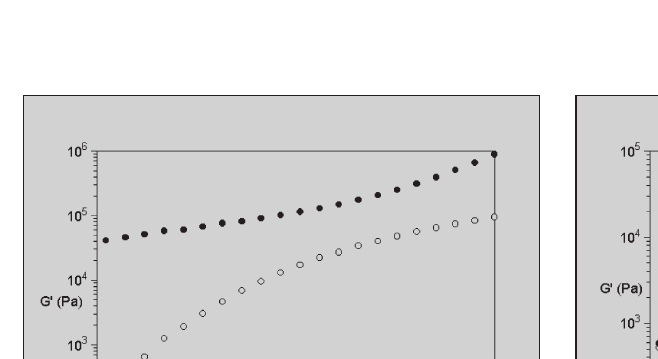
Figure 1 (left): Storage modulus as a function of frequency for iBMA at two temperatures ( (cid:122) : 80°C; (cid:129) : 160°C). Figure 2 (right): Influence of annealing at 125°C on the storage modulus of a heterogeneous blend at 160°C. ( (cid:129) : without annealing; (cid:122) : sample annealed during 4